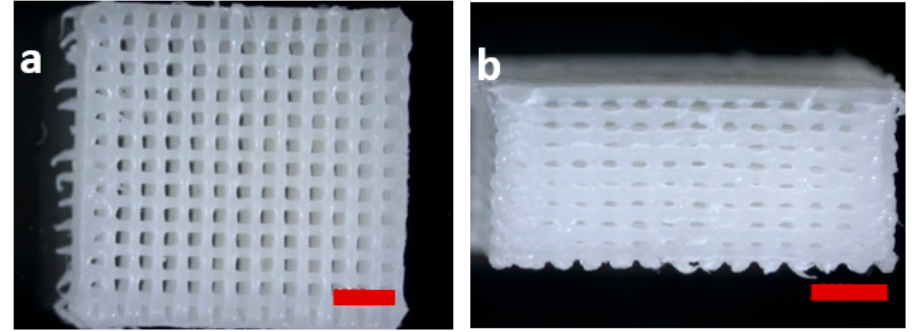
Figure 6. Stereomicroscope images of a plotted PCL-PEG (7030) scaffold as fabricated: topview ( a ); and side view ( b ) (scale bar = 2 mm). and side view ( b ) (scale bar = 2 mm).